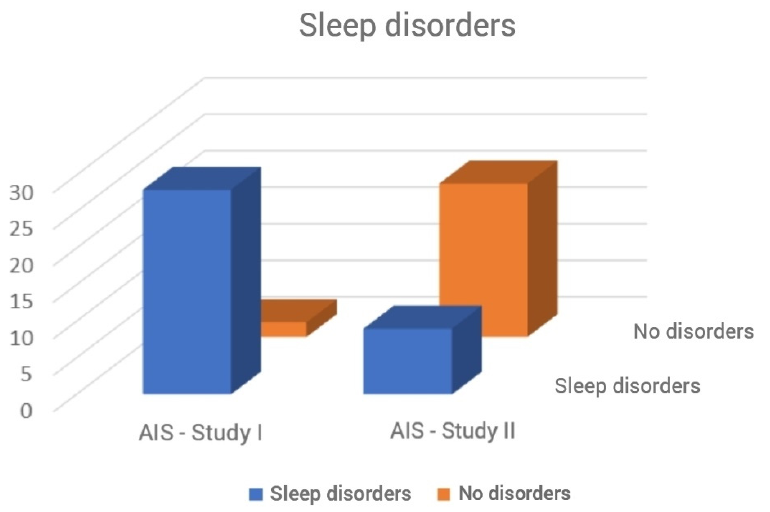
Figure 1. Frequency of sleep disorders (Chi-square test). AIS, Athens Insomnia Scale. Chi2 = 25.45; p < 0.001. Table 2. Results achieved by patient on the scales during the first and second studies (Wilcoxon test).